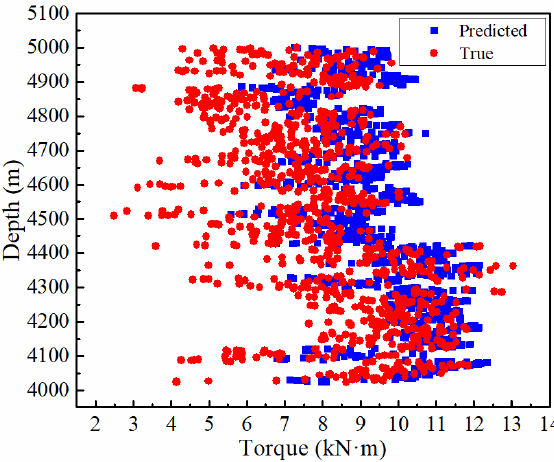
Figure 3. Comparison of predicted and true TOB. The BP-LSTM neural network is used to realize the real-time prediction of WOB and TOB, which lays a foundation for the real-time inversion of friction